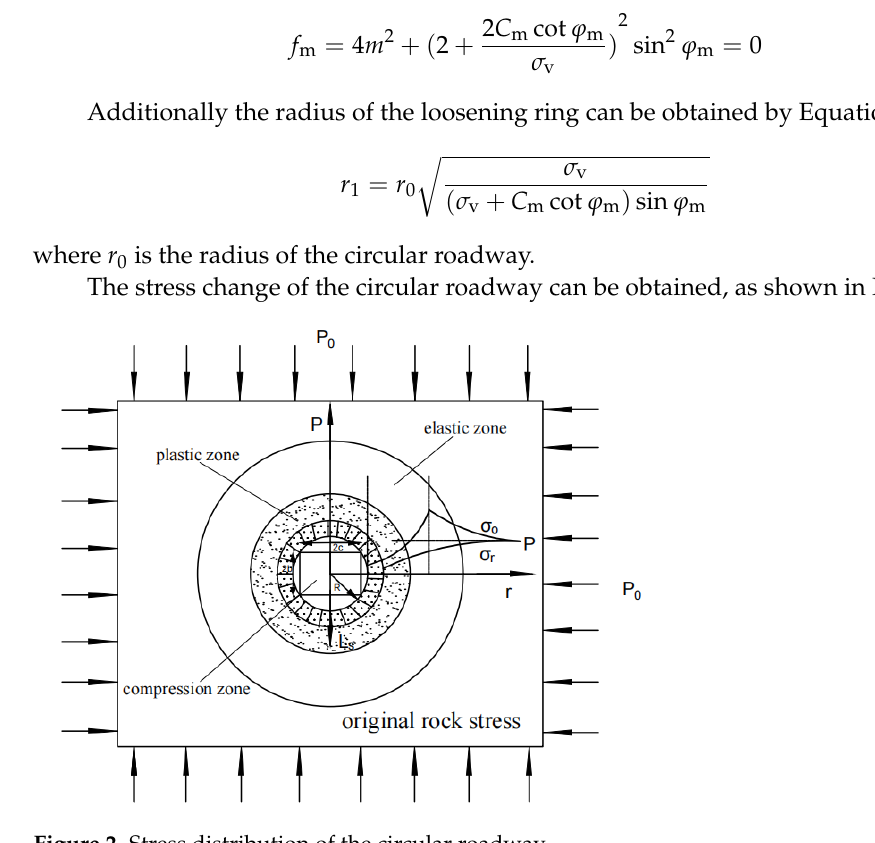
Figure 2. Stress distribution of the circular roadway.